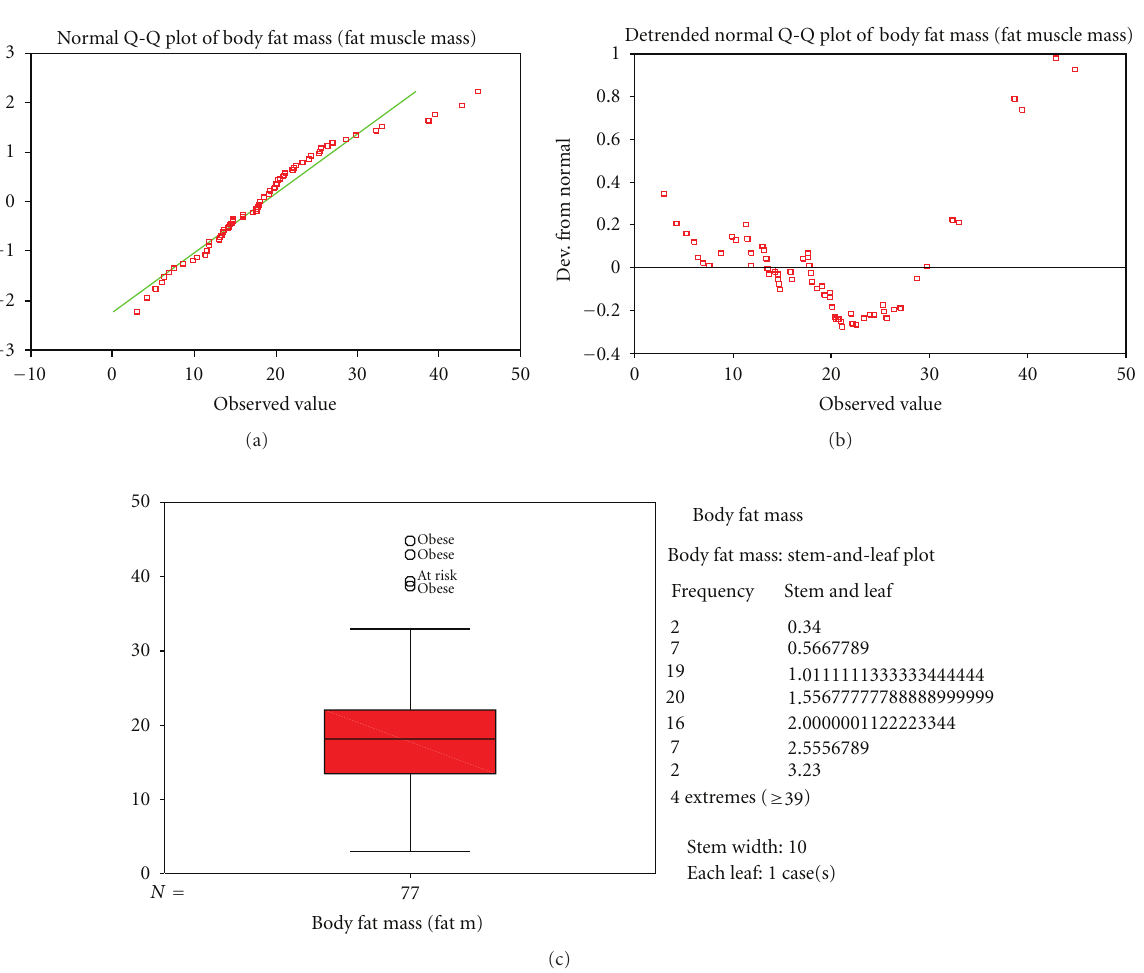
against obese group (29 . 31 ± 3 . 95 kg/m 2 ), P < 0 .